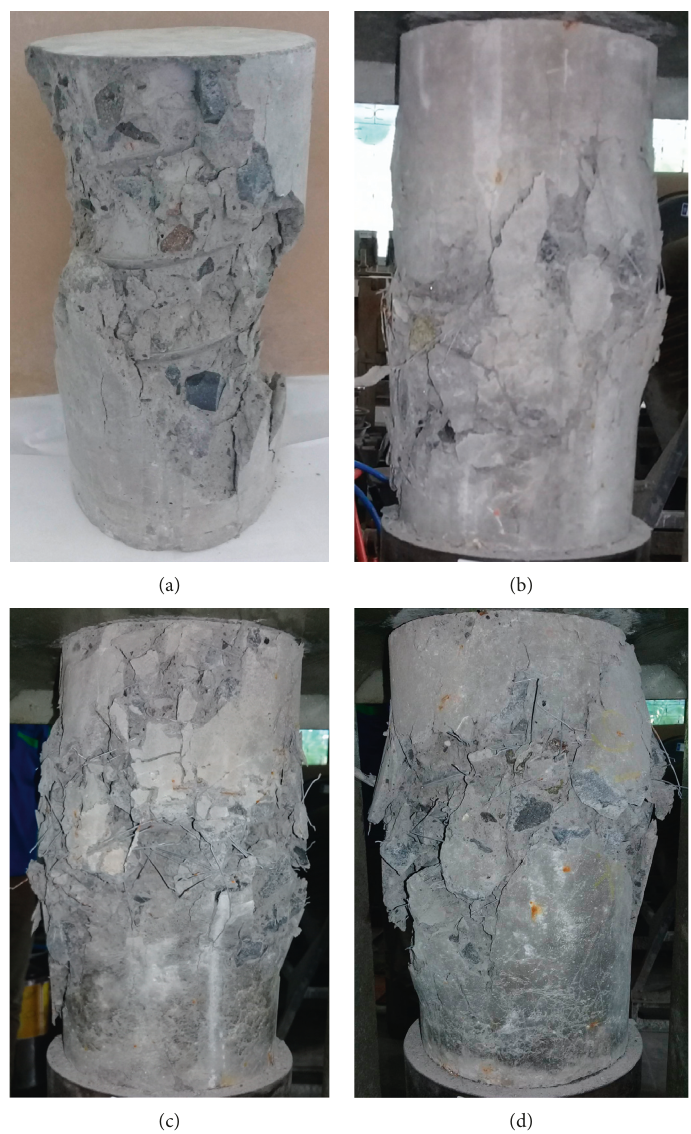
WF , (b) specimen C F1 , (c) specimen C F2 , and